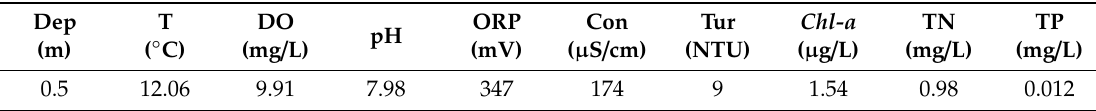
Table 2. Water quality of the sampling